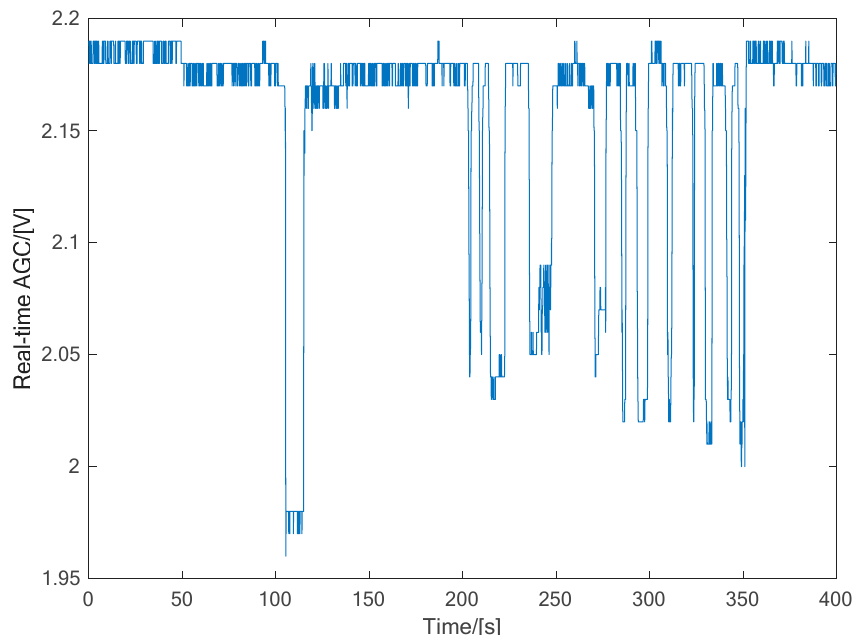
Figure 15. Real-time AGC of SOTM of the conventional method.